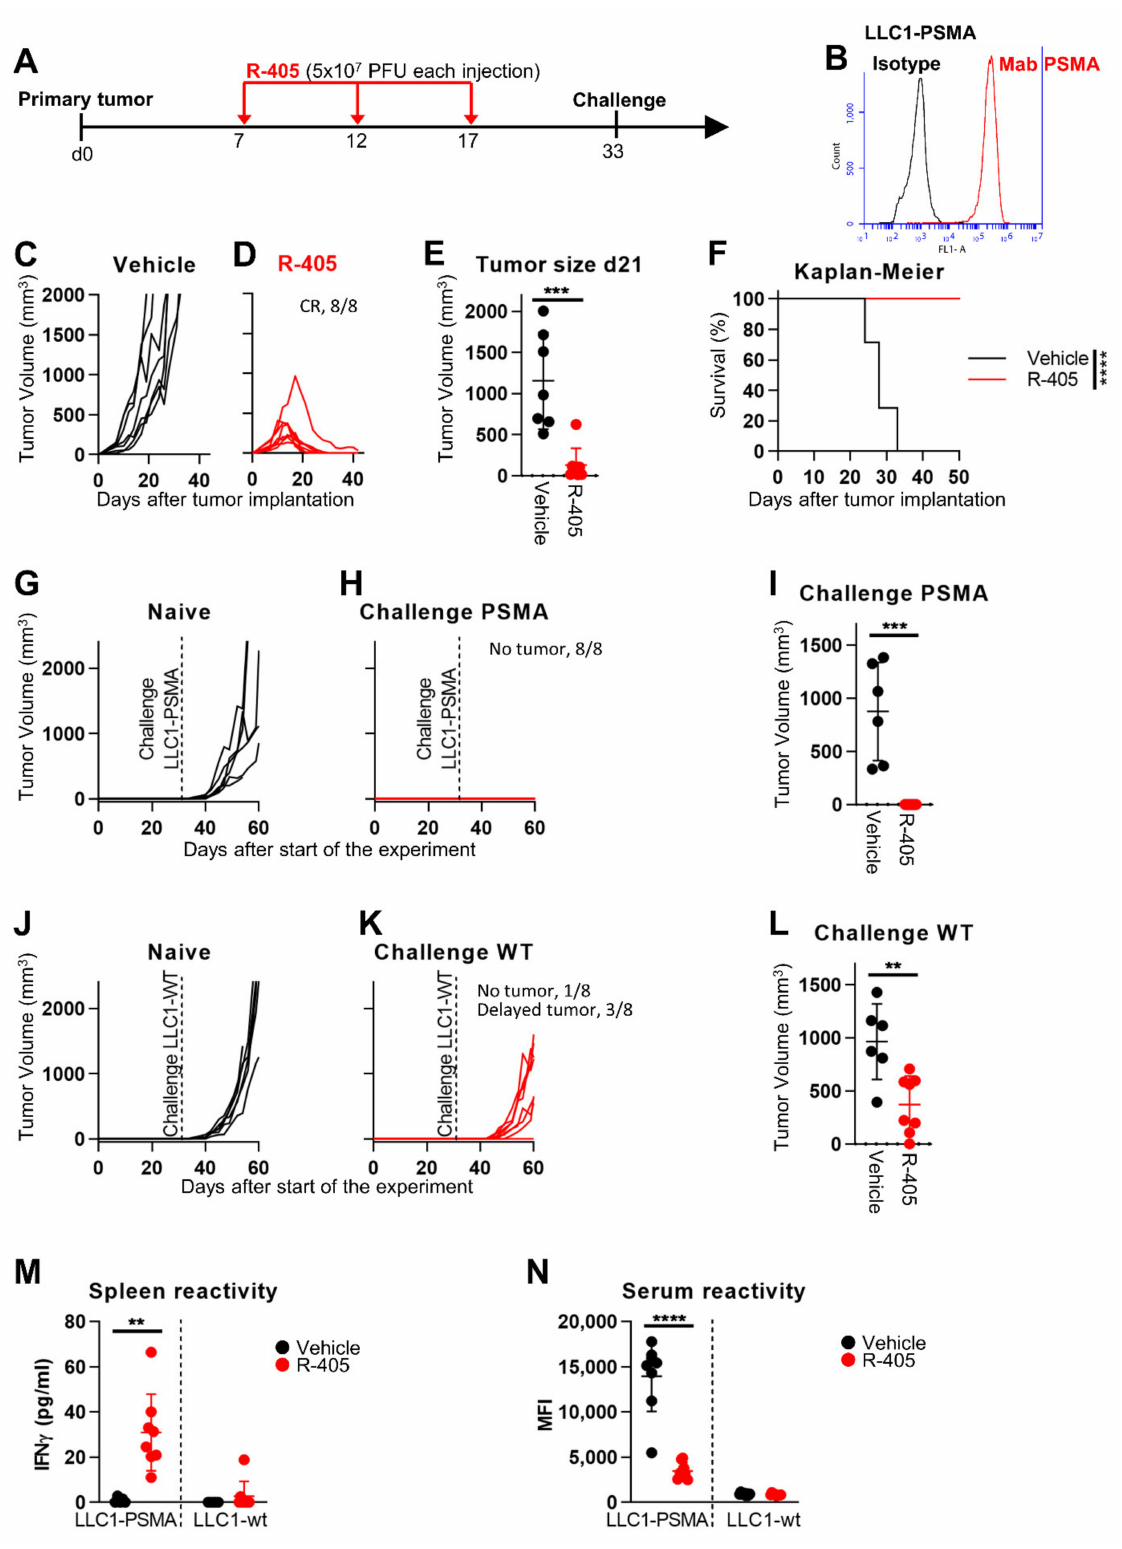
Figure 3. Efficacy of R-405 monotherapy on the growth of LLC1-PSMA tumors. ( A ) Schedule of treatments. Six-to-eight weeks old C57BL/6 mice were s.c. implanted in the left flank with 1 × 10 6 LLC1-PSMA cells in 100 µ L of PBS,